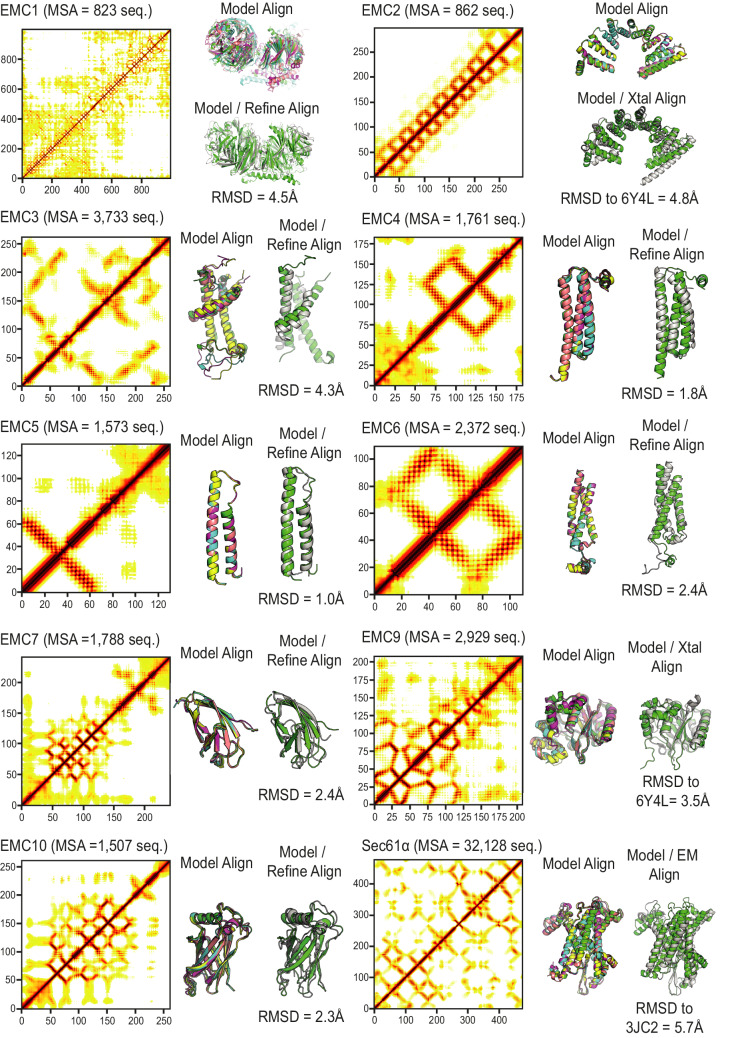
Ab initio prediction of EMC subunit structure and flexible fitting using real-space refinement.Structures were predicted for 9 EMC subunits using the trRosetta server. The best ranked solution for each subunit was then docked into the cryo-EM density and subject to real-space refinement in PHENIX. Number of alignments in the multiple sequence alignment (MSA) is indicated along with the resulting distance contact heat map. The top five ranked models were aligned for the core folds used in EM docking to show modelling confidence. A comparison of the model before and after real space refinement illustrates only subtle changes (green vs grey, RMDS is indicated). Soluble and membrane proteins (EMC2, EMC9, and Sec61a) were modelled and compared to their known structures.